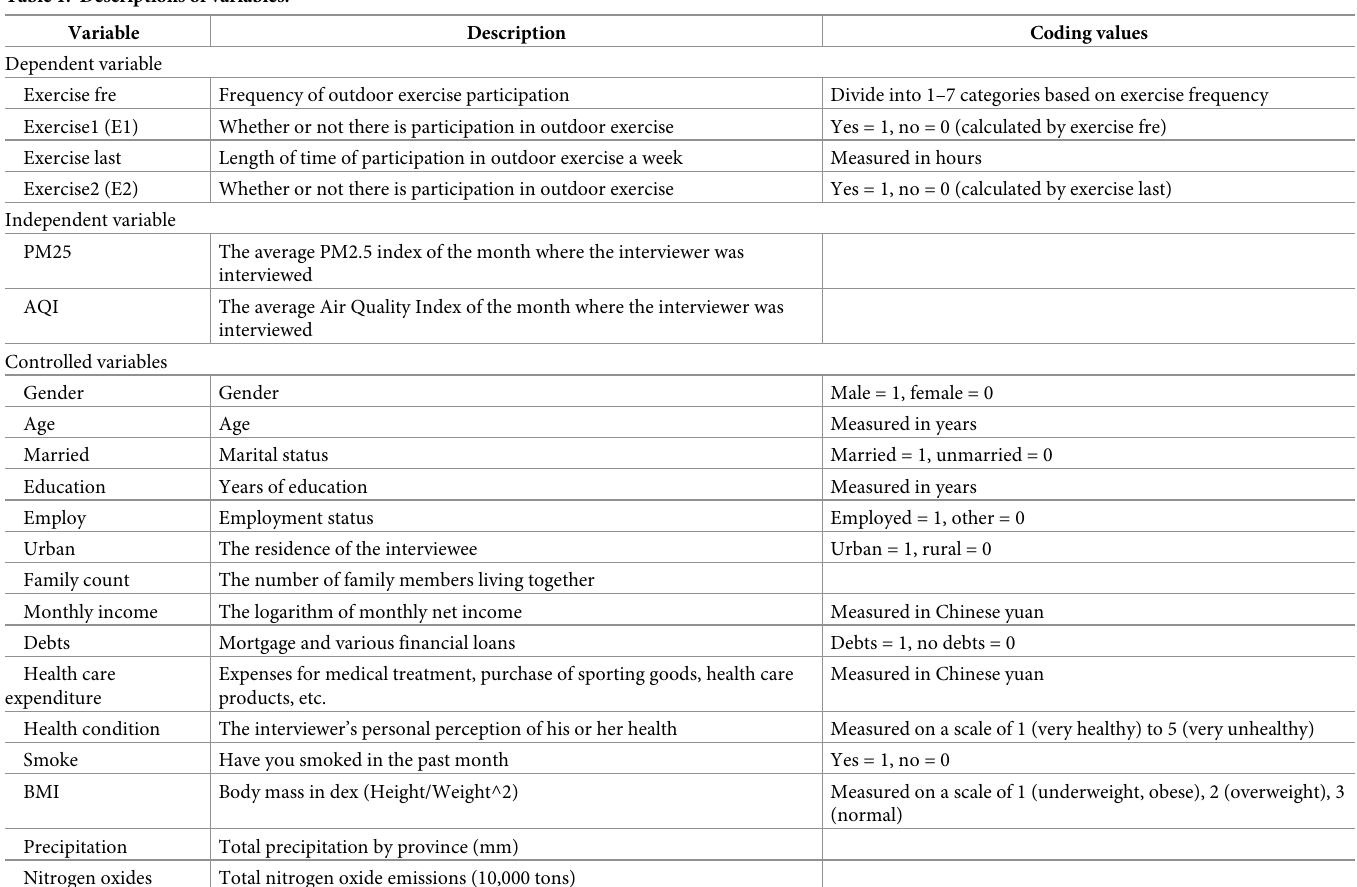
Table 1. Descriptions of